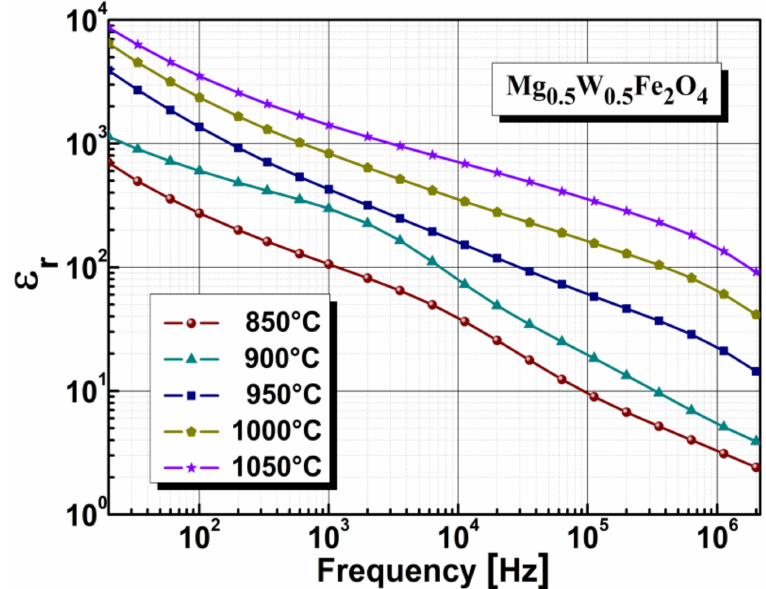
Figure 3. The effect of annealing temperature on the relative